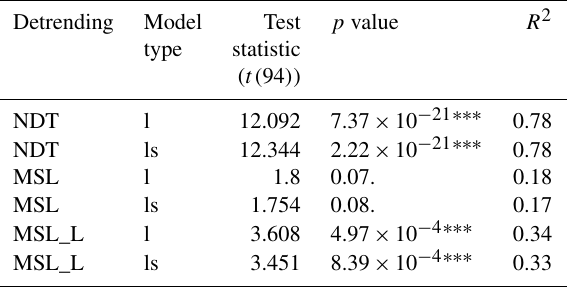
Table 3. Comparisons between the rates fitted by the point process (PP) for Venice and the empirical process rate of models with co- variates on the location (model type l) and models with covariates on the location and scale (model type